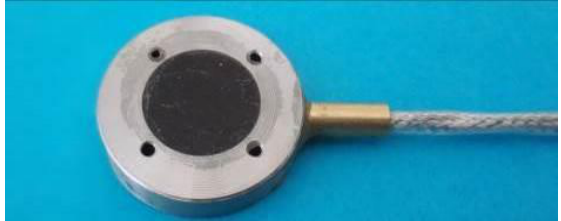
Figure 4. The carbon resistance pressure sensor.